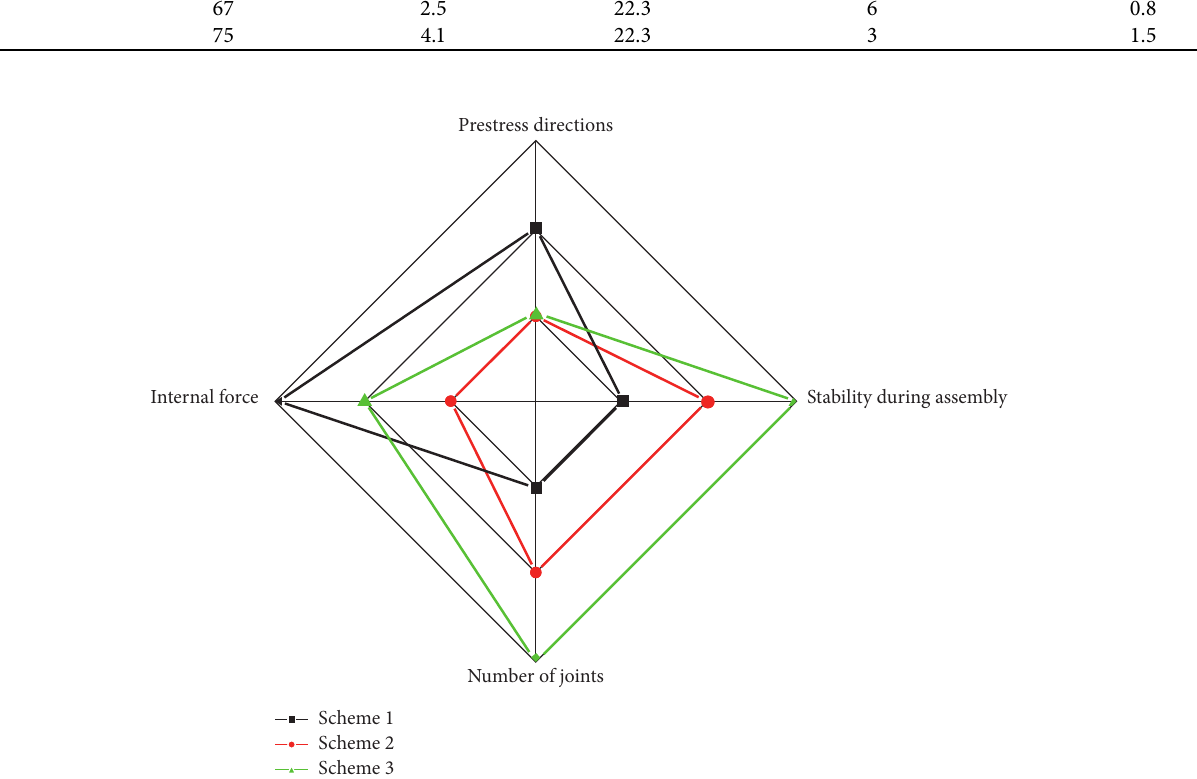
Figure 7: Comparison of the three schemes.